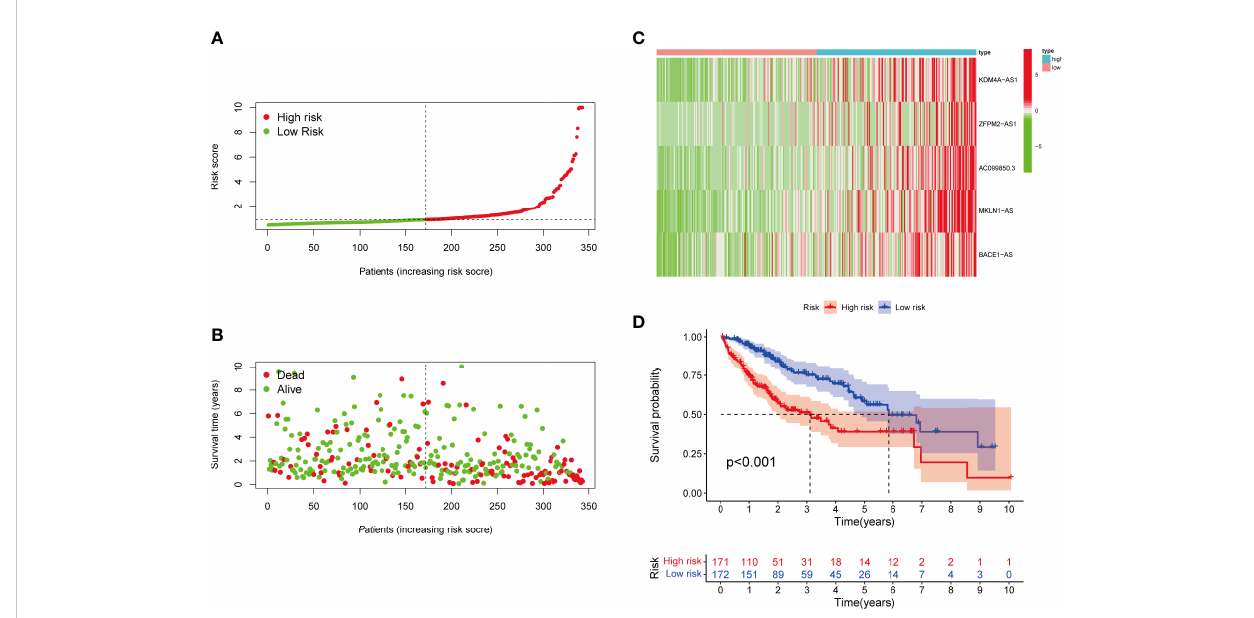
FIGURE 4 (A) Risk score distribution of patients with LIHC in the high- and low-risk groups. (B) Survival status of patients in the high- and low-risk groups. (C) Heat map of the expression of ferroptosis- and necroptosis-related lncRNAs (F-NLRs) in the high- and low-risk groups. (D) Overall survival analysis of patients in the high- and low-risk